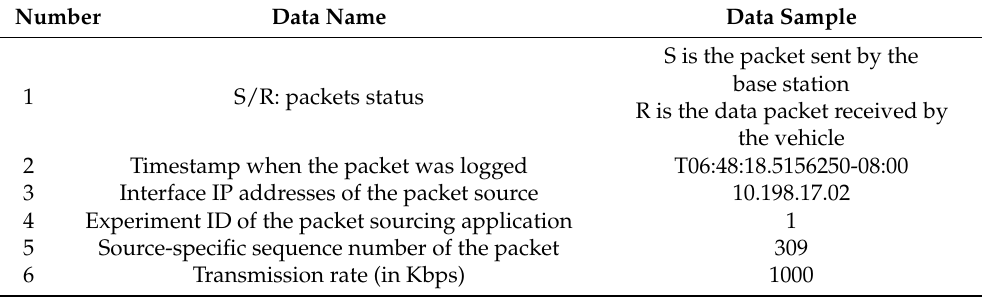
Table 4. Vehicle data